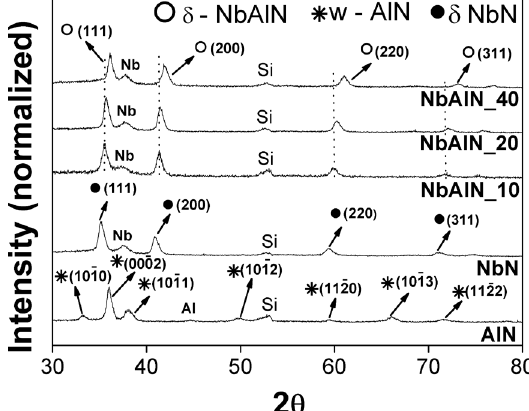
Figure 1. RBS result for the NbN and Nb